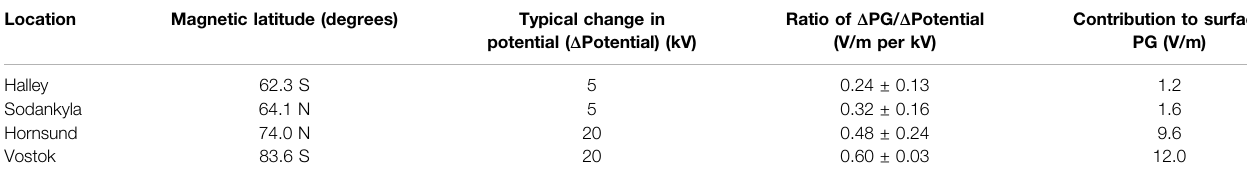
TABLE 3 | Summary of effect of cross-polar-cap potential differences at various high latitude sites. Location